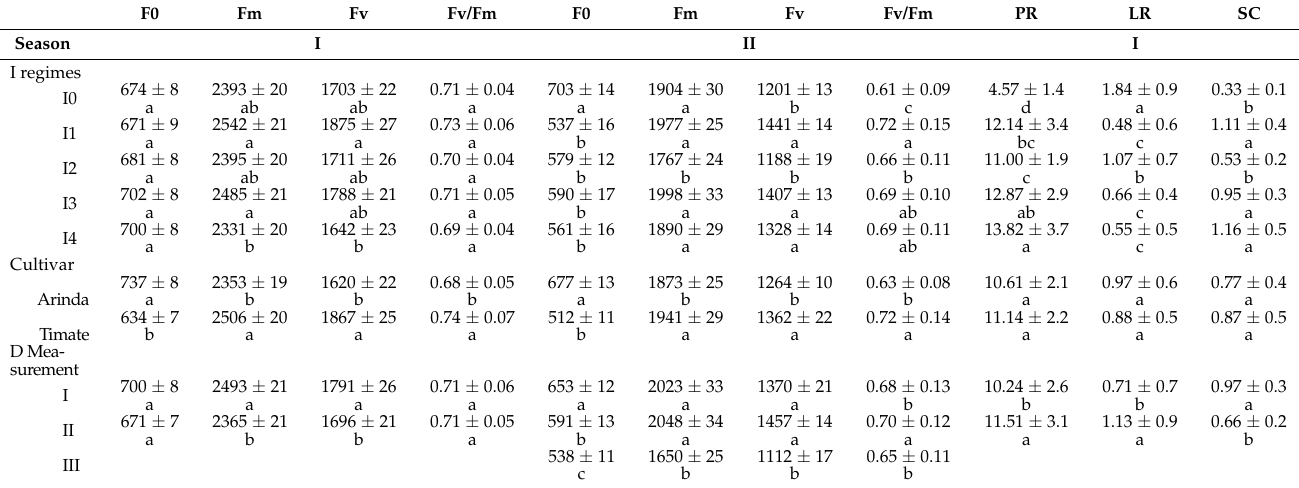
Table 4. Eco-physiological traits as affected by the main factors in Seasons I and II.